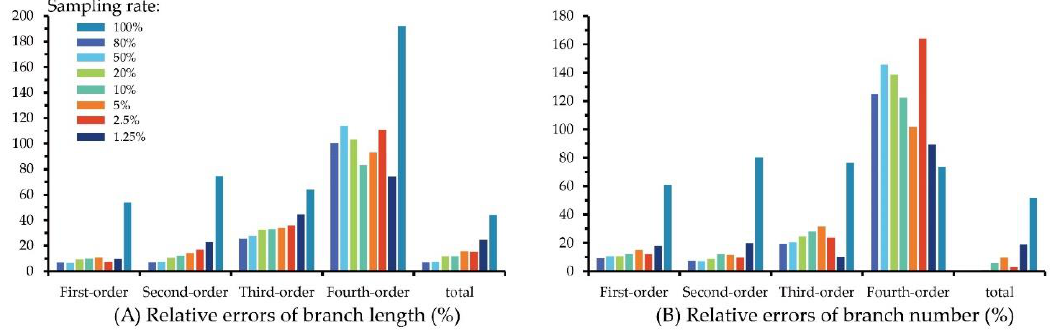
Figure 11. Relative errors of a different number of point clouds. ( A ) Relative errors of branches length; ( B ) relative errors of branches number.